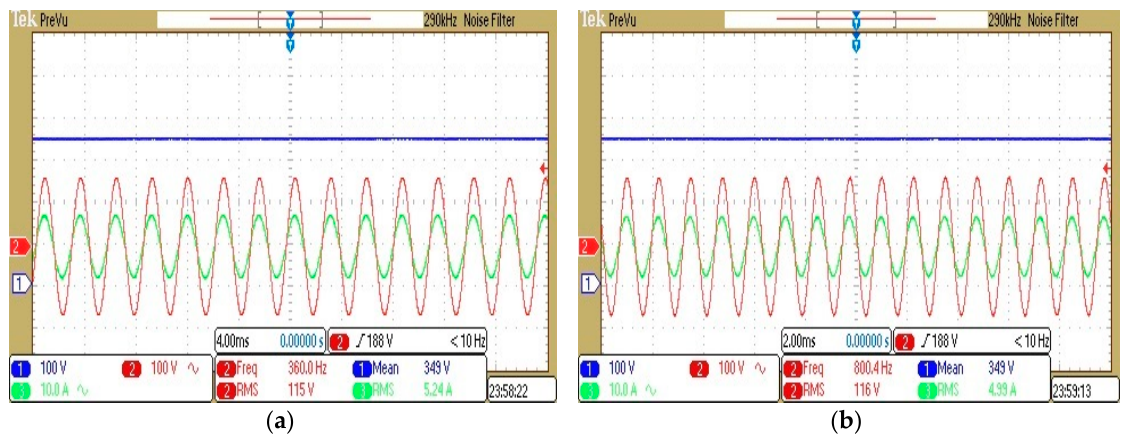
Figure 19. The input voltage and current waveform during variable frequency conditions. ( a ) The waveform of rectifiers operated at 360 Hz; ( b ) The waveform of rectifiers operated at 800 Hz.